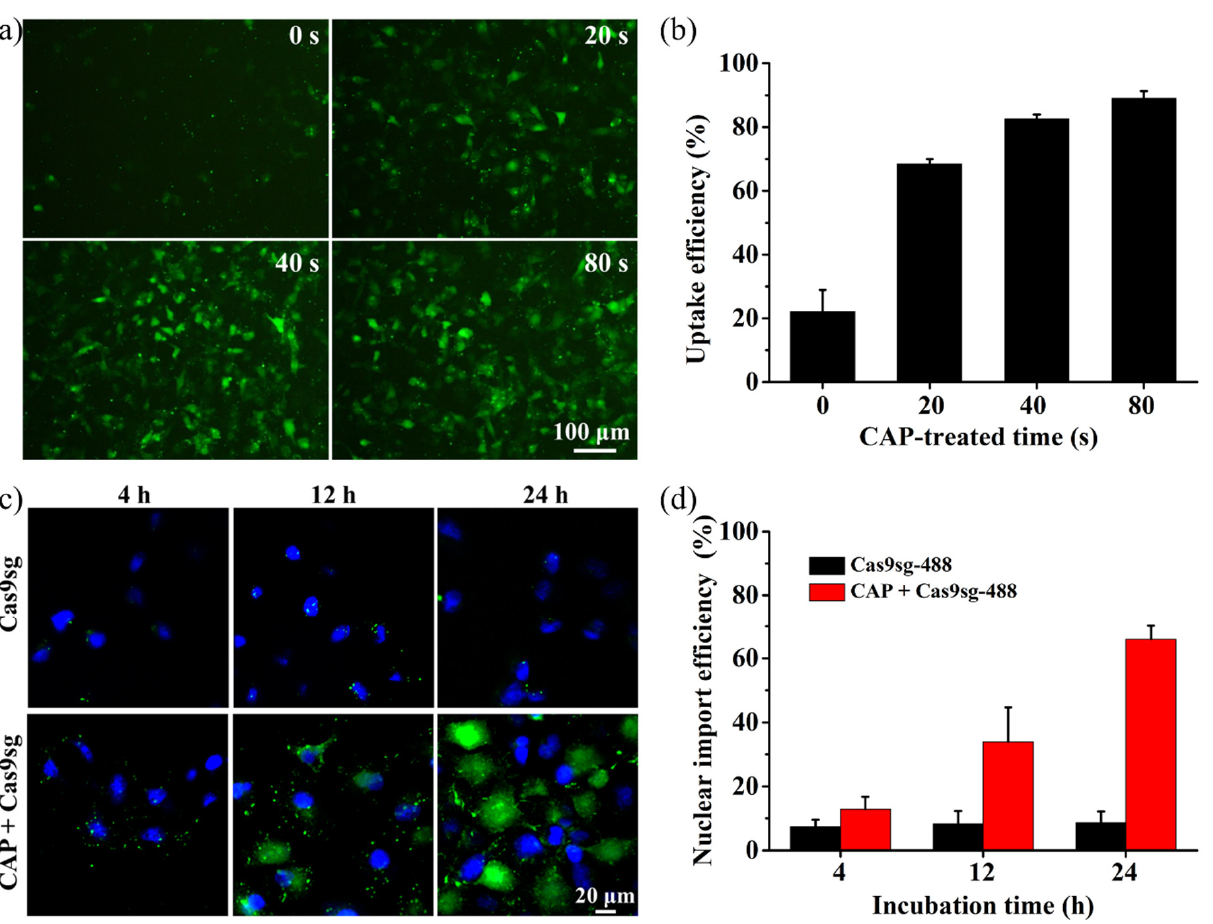
Figure 2. CAP-mediated cellular transport of Cas9sg: ( a ) Fluorescence imaging of the MCF-7 cells treated with Cas9sg-488 for 24 h after CAP exposure for various time periods; ( b ) Uptake efficiency of Cas9sg-488 in MCF-7 cells 24 h after CAP exposure for various time periods determined by flow cytometry; ( c ) Confocal fluorescence imaging and ( d ) Nuclear import efficiency of MCF-7 cells treated with Cas9sg-488 for different time intervals after CAP exposure for 80 s (C Cas9sg-488 = 8 nmol L − 1 ). The data are shown as mean ± SD ( n = 3).